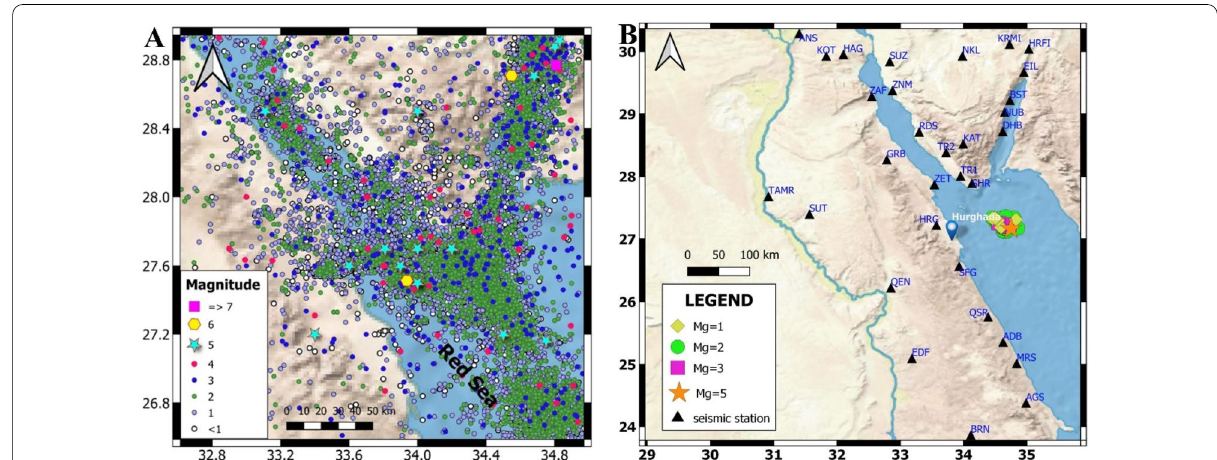
Fig. 2 A Seismicity of the northern Red Sea, Gulf of Suez and Gulf of Aqaba based on the compiled earthquake catalogs. B The selected dataset and the recorded seismic